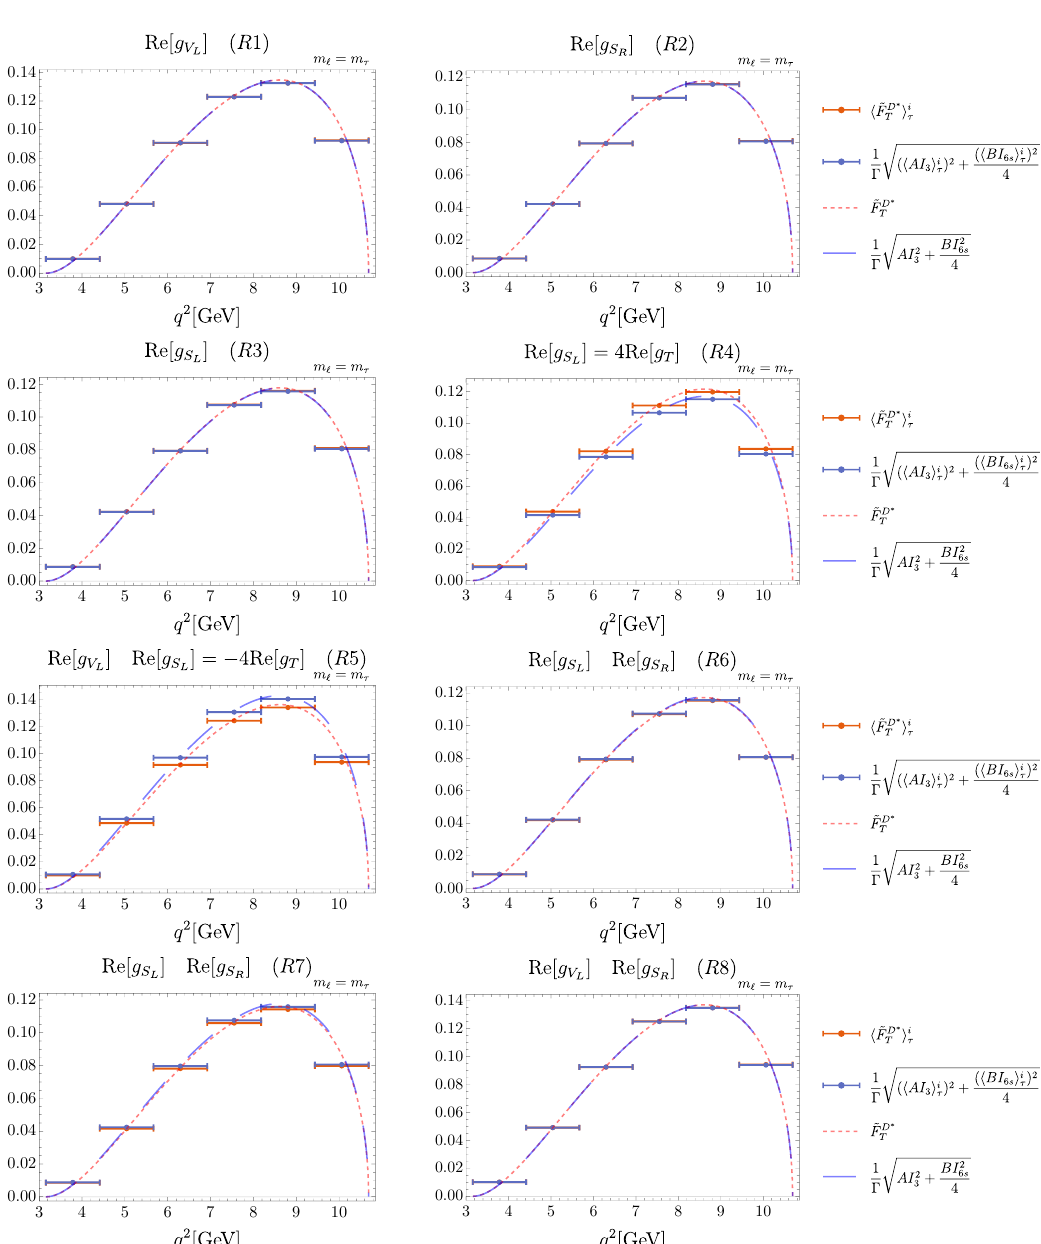
Figure 4. Study of binning e(cid:11)ects for eq. (4.18) for benchmark NP scenarios with real contribu- tions.